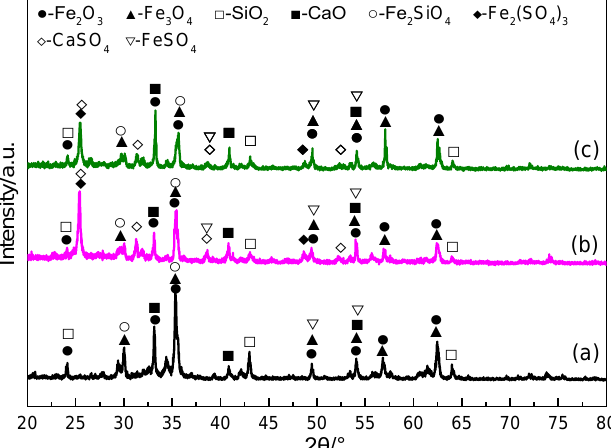
Figure 1. XRD patterns of the catalysts: SOC ( a ), SSOC ( b ) and SSOC after tested ( c ).